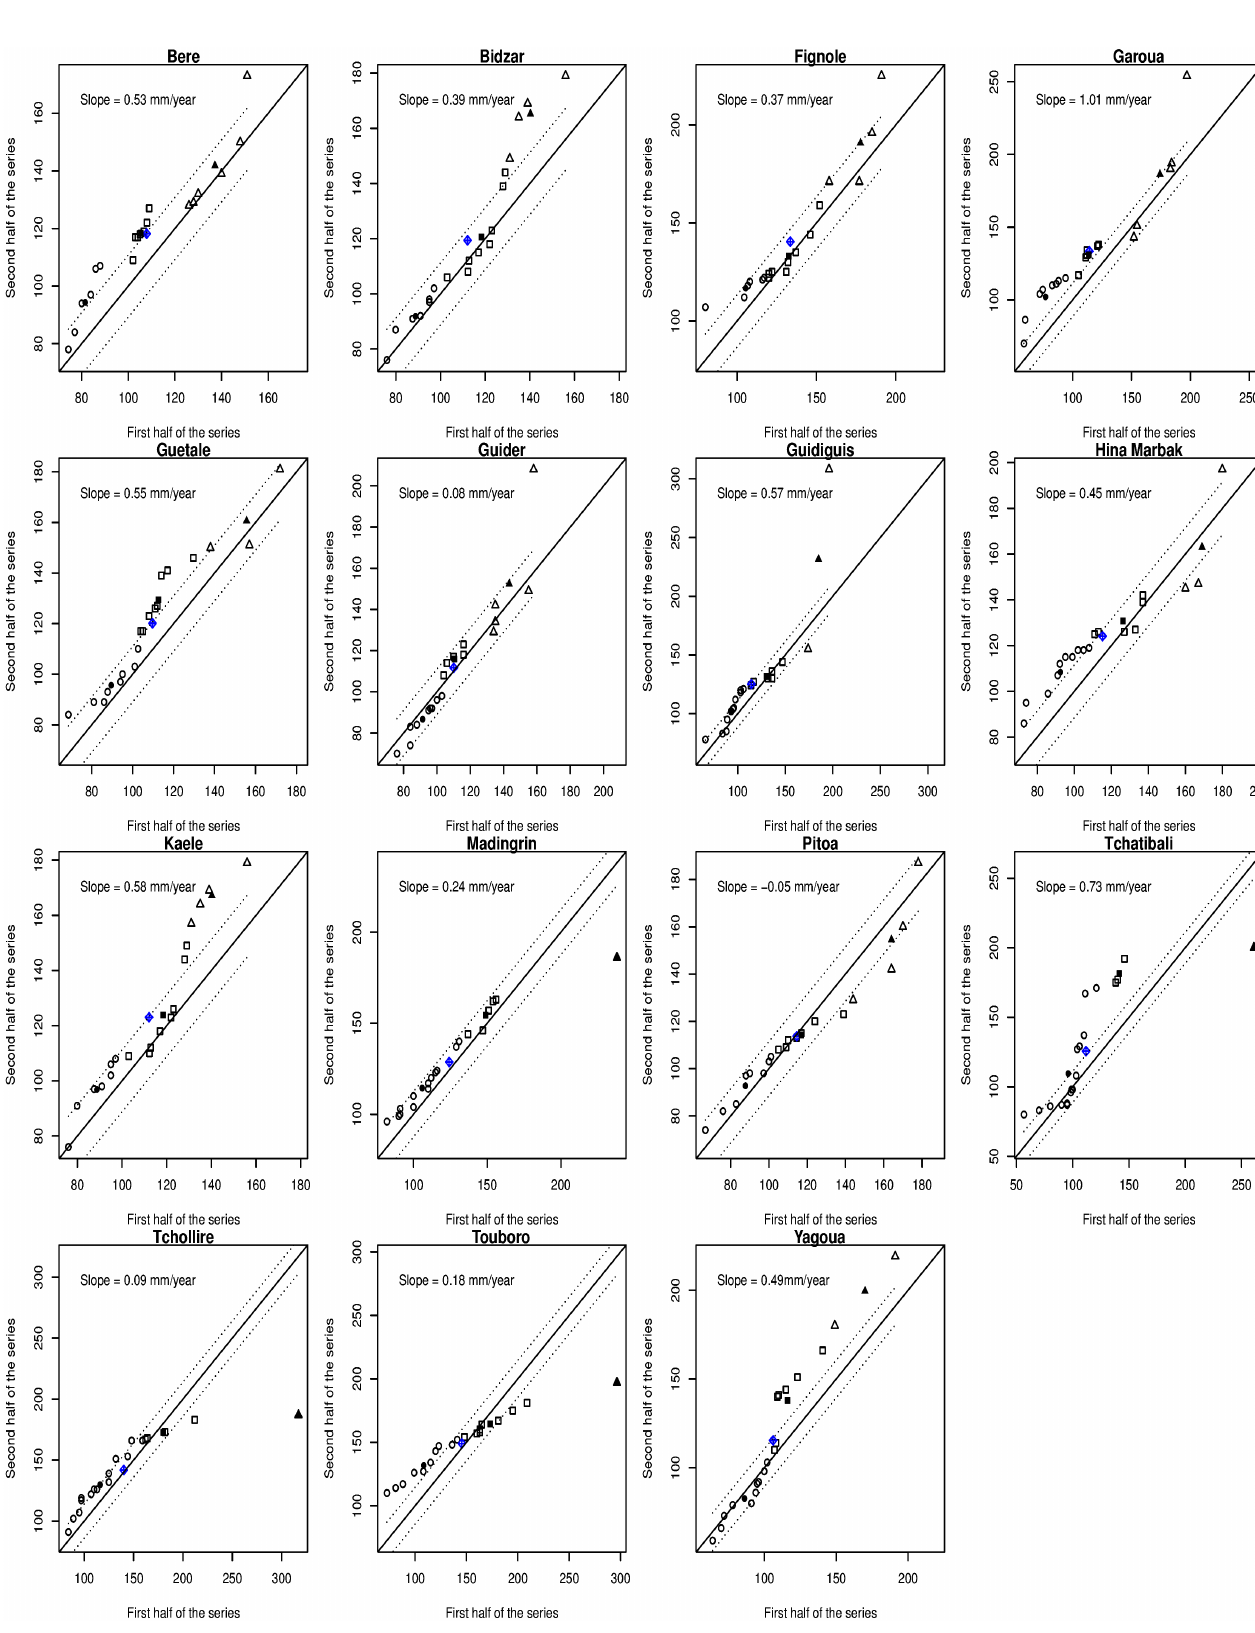
Figure 7. As in Figure 6, but for Rx5day.